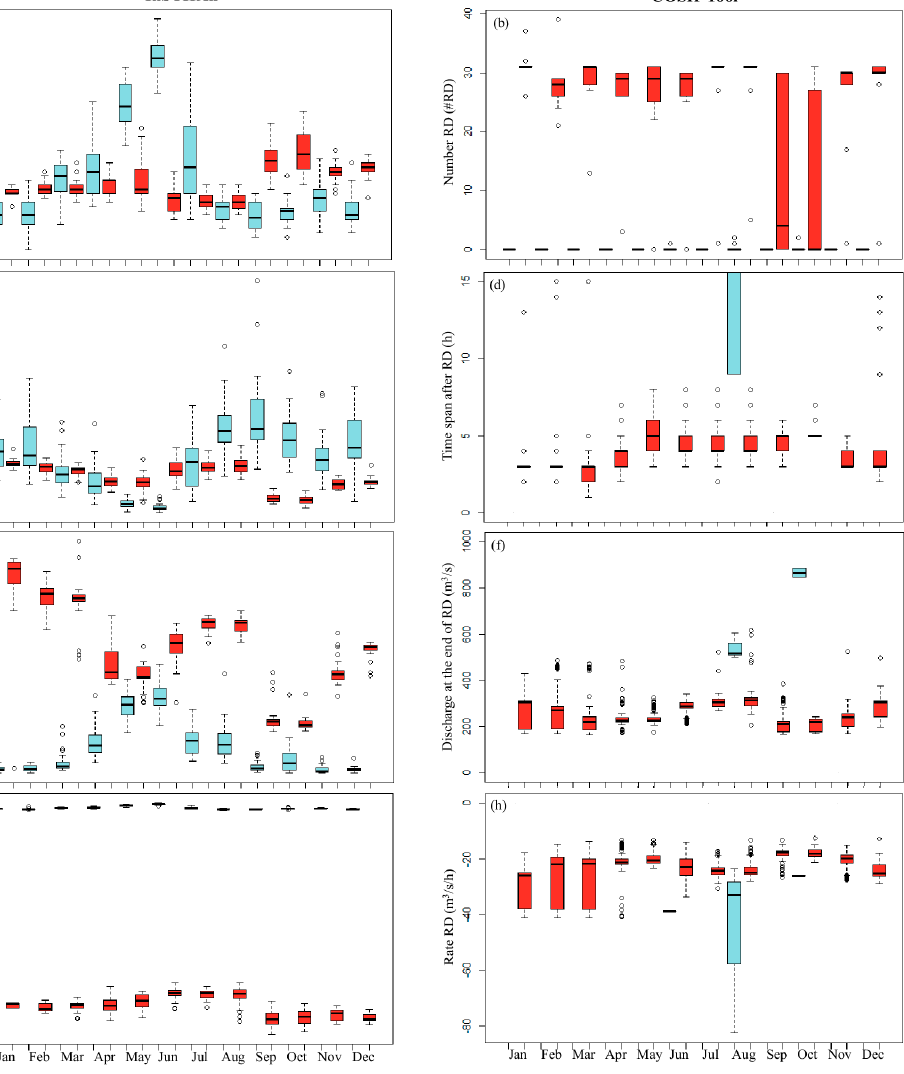
Figure 3. Box-and-whisker plots for selected outputs from the characterization analyses ran in InSTHAn and COSH-Tool for the pre- and post-dam (Glen Canyon dam) flow series (1943–1951 hourly flows, and 2003–2011 every-15 min flows, respectively) along the downstream reach of the Colorado River. y -axes represent the months in pre- (natural) and post-dam (perturbed) conditions, colored in blue and red, respectively. Black lines in the middle of the boxes are the median values for each group. The vertical size of the boxes is the interquartile range (IQR). The whiskers represent the minimum and maximum values that do not exceed 1.5 × IQR. The points are outliers. x -axes represent the characterization metrics related to frequency, duration, magnitude and rates of change provided by InSTHAn (i.e., short-term characterization indicators (STCI); a , c , e , g ) and COSH-Tool ( b , d , f , h ). For InSTHAn, selected metrics are: ( a ) monthly average number of fall periods per day for the whole flow series, ( c ) monthly average duration of fall periods per day for the whole flow series, ( e ) monthly average amplitude per day for the whole series and ( g ) monthly average rate of flow decrease per day for the whole series. For COSH-Tool, the selected metrics are: ( b ) total number of rapid decreases per month for the whole series, ( d ) time span after rapid decreases per month for the whole series (not shown were three values in June, August and October for the natural period, which were higher than 15 h), ( f ) discharge after rapid decreases per month for the whole series (not shown was one value in June for the natural period, which was higher than 1000 m 3 / s) and ( h ) rate of flow decrease of rapid decreases per month for the whole